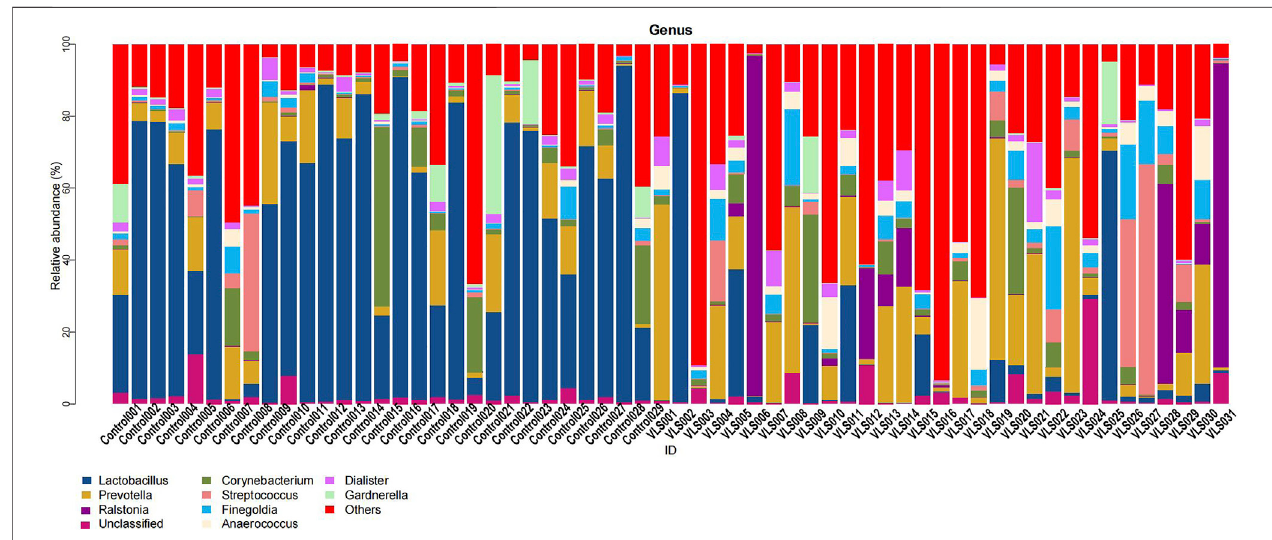
FIGURE 5 | Species ’ relative abundance map at the genus level of the VLS and control groups.